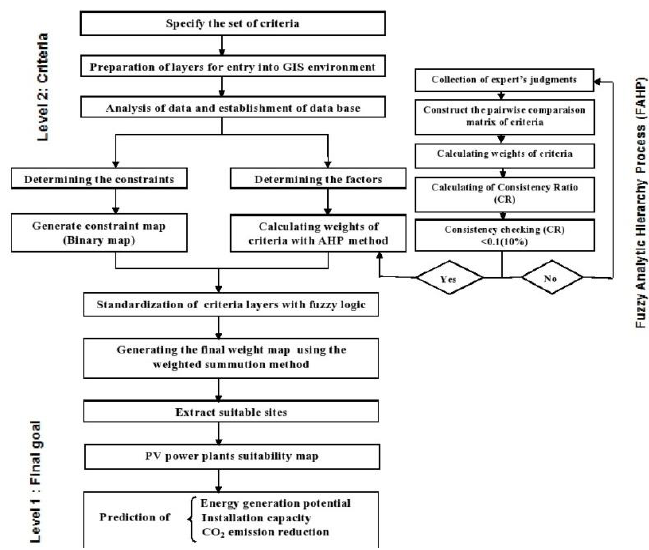
Figure 1. Flow chart of proposed methodology